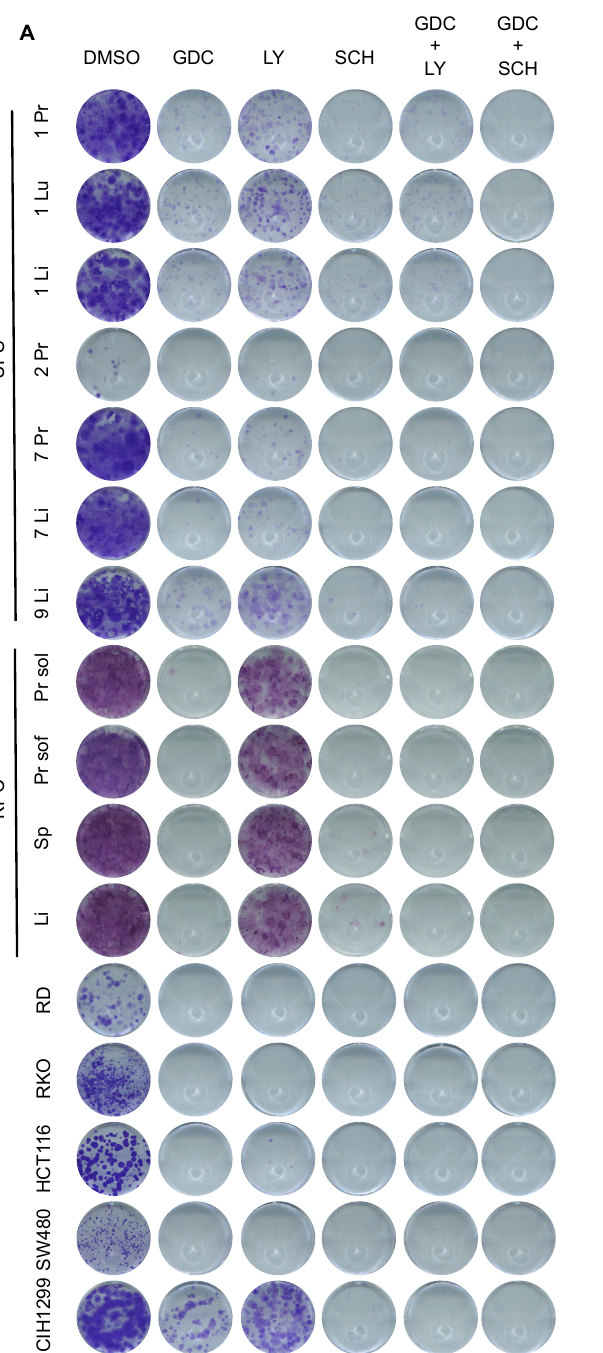
Figure 4. Dual MEKi plus ERKi prevents the emergence of drug resistance. ( A ). Examples of colony forming assays of the indicated cell lines cultivated for 14 days with the indicated inhibitors (1 µ M). ( B ). Long-term drug resistance assay. The indicated sub-confluent cell lines (5 × 10 5 cells/6 cm plate) were cultivated with the indicated inhibitors (1 µ M). Days to resistance represents the timepoint at which cells were first split and continued proliferation thereafter, cells that did not survive the treatments or proliferate within 4 months are depicted in